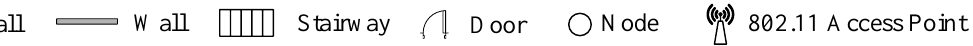
Figure 1. Experimental field: the corridor of the laboratory building with uncontrollable interference sources in nearby rooms.